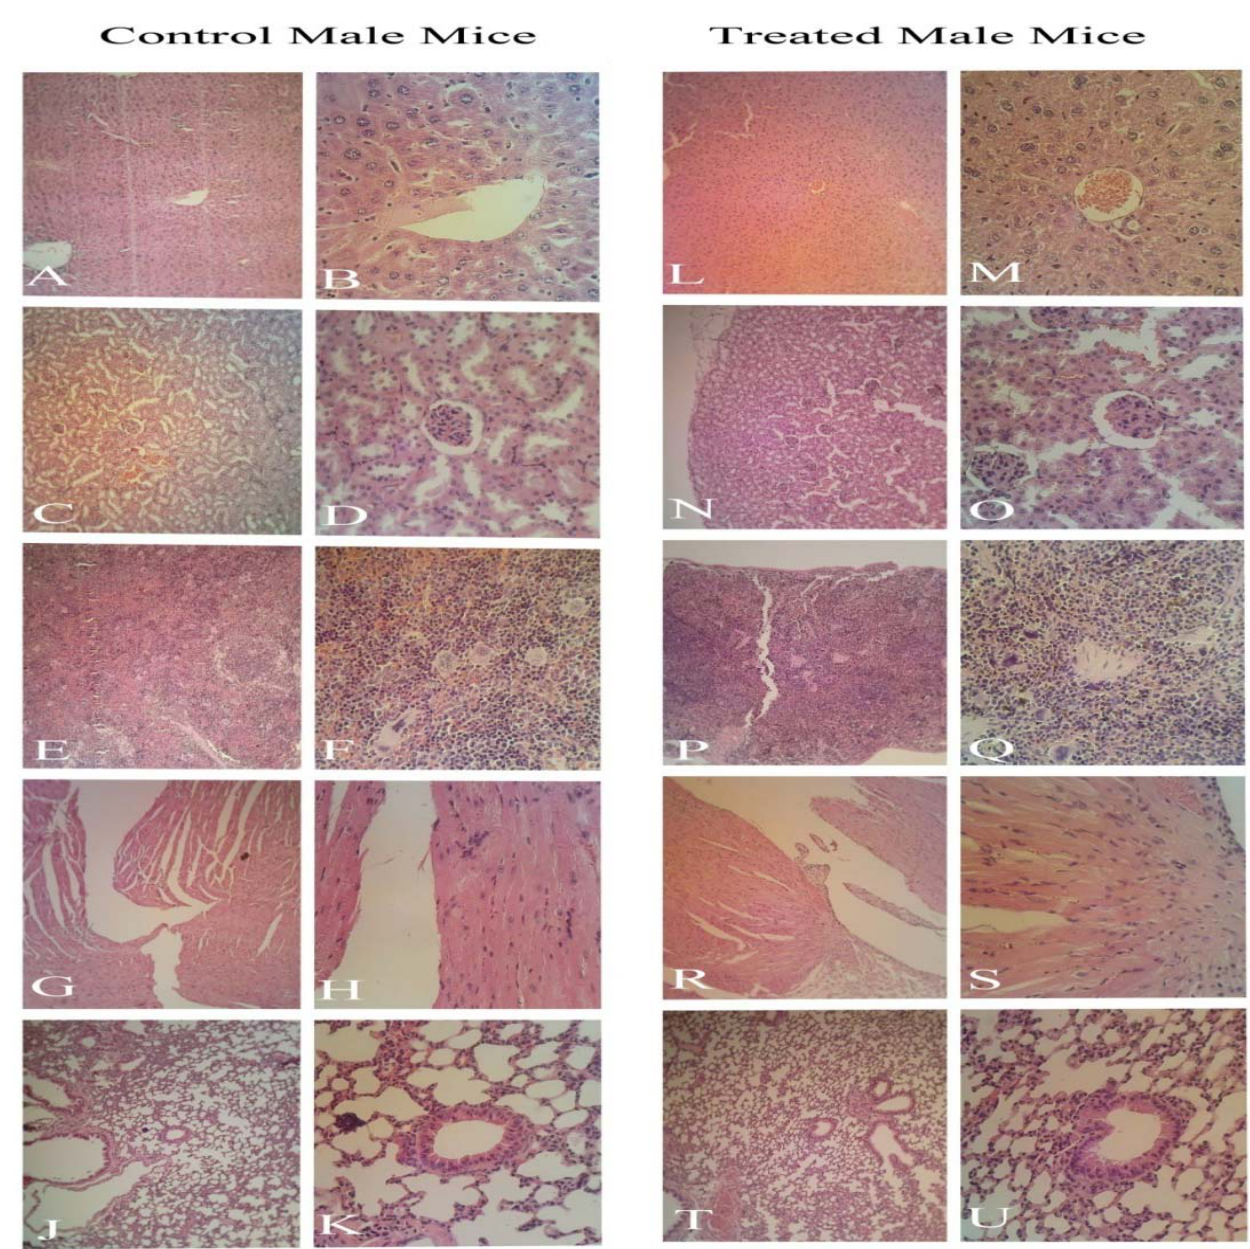
Figure 3. Histological (male mice) examination of A, B, L, M: Liver; C, D, N, O: Kidney; E, F, P, Q: Spleen; G, H, R, S: Heart; J, K, T, U: Lung. Magnification for left side slides of each category is 100×; right side, 400×. The focus of picture at the center in 400× magnification is on central vein in liver, glomerule in kidney, white pulp in spleen, terminal bronchiole in